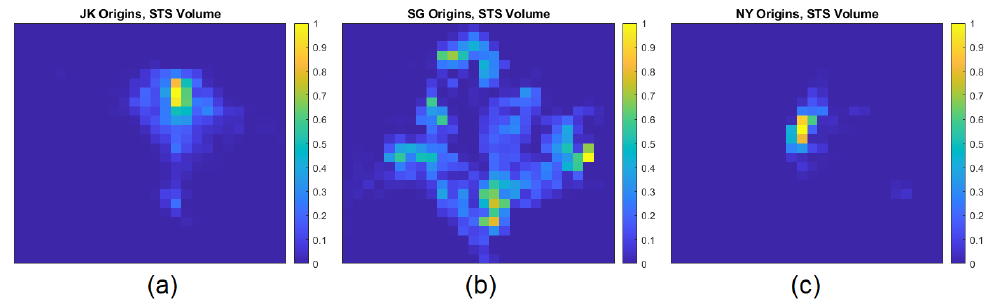
Figure 1. STS Vehicular capacity of ( a ) Jakarta, ( b ) Singapore, and ( c ) New York.